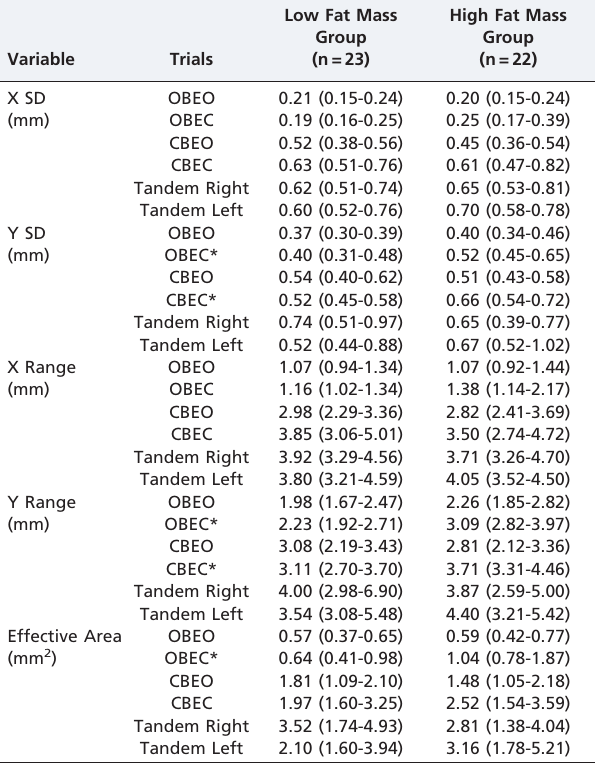
Values are expressed as the median (1 st – 3 rd quartile) for numerical variables and as the absolute number (percentage) for categorical variables. BMI = Body Mass Index; RUS = right unilateral stance; LUS = left unilateral stance; Fat % = Fat percentage; FFM = Fat-free mass. * p , 0.05 (Low Fat Mass Group vs . High Fat Mass Group; Mann Whitney Test for numerical variables and chi -square test for categorical variables). southern Brazil 11 but were slightly lower when compared to data collected in a US study, 5 probably due to the use of different equations 11,31 to calculate this variable. Table 2 - Stabilometric variables for High and Low Fat Mass Groups.